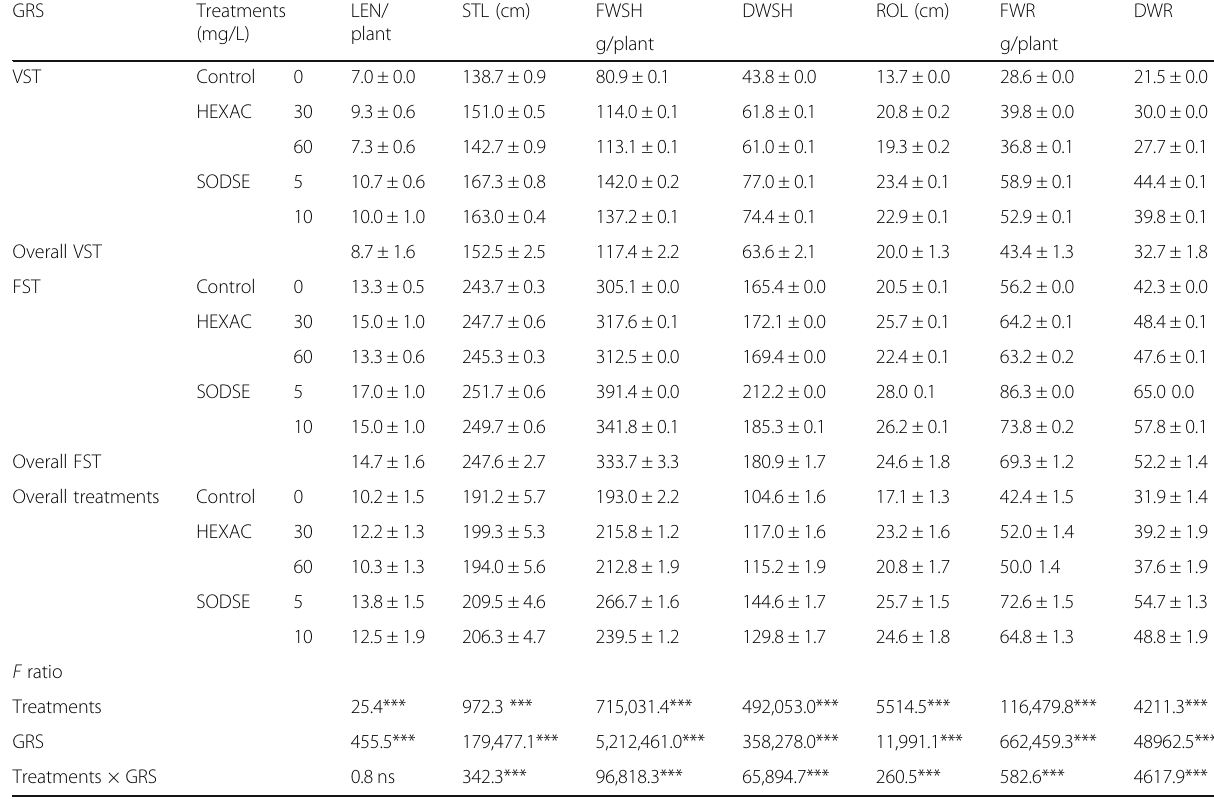
Table 1 Effect of HEXAC or SODSE on the MCH GRS Treatments